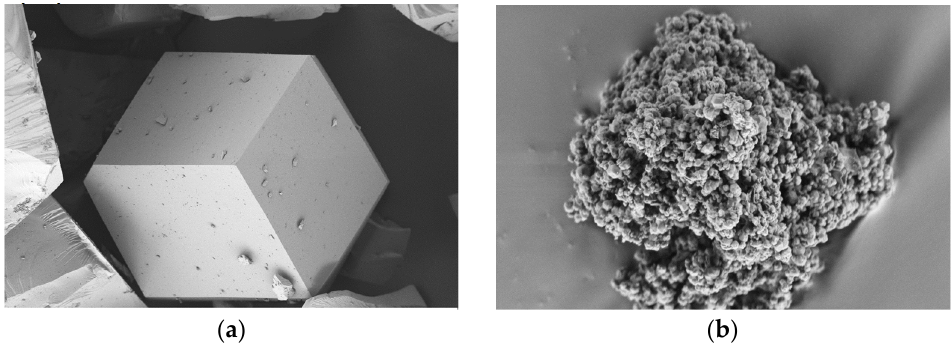
Figure 3. SEM images of as-synthesized ( a ) ZIF-8 and ( b ) ZIF-90. Nitrogen physisorption and the BET method were used to determine the specific surface area of activated ZIF-8 and ZIF-90. Table 3 shows that the specific surface area of ZIF-90 was approx. 1.8 times higher than the specific surface area of ZIF-8. Similarly, the total pore volume of ZIF-90 was 0.571 cm 3 /g which was 2.3 times higher than that of ZIF-8 (0.252 cm 3 /g). Figure 4 shows the nitrogen physisorption isotherms ((a) and (b)) as well as the pore size distribution ((c) and (d)). The major difference that was noted from Figure